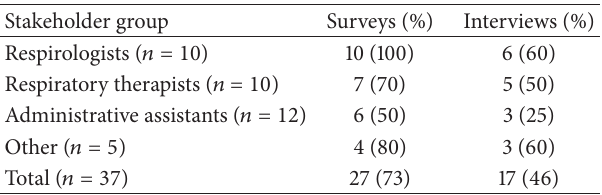
Table 1: Survey and interview response rate for each stakeholder